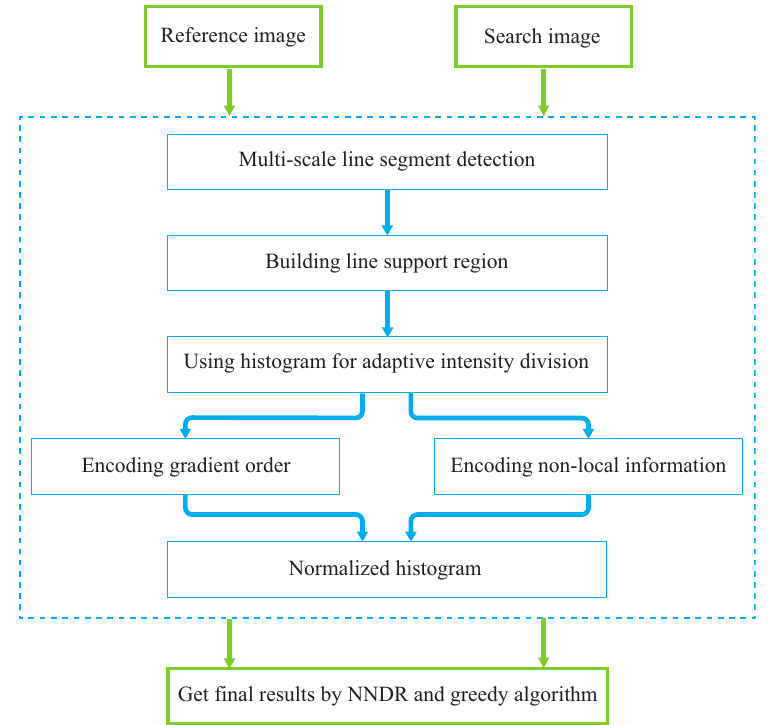
Figure 1. The proposed approach